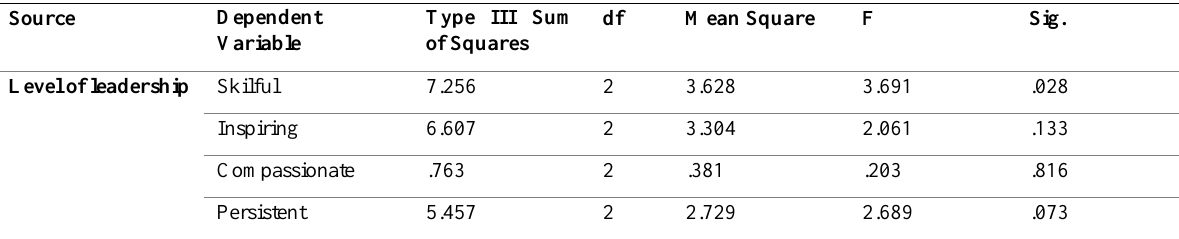
Table 9: Tests of Between-Subjects